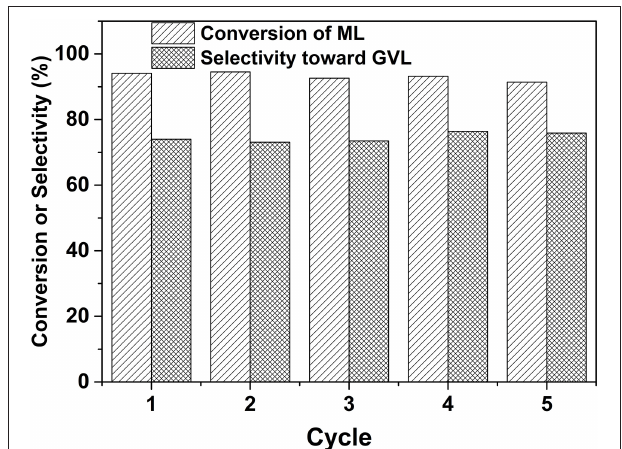
FIGURE 11 | Durability test of 2.0% Ru/11.7% SiW@UiO − 66 for the conversion of ML to GVL. Reaction conditions: 0.257g of ML, 50mg of catalyst, 15mL of H 2 O, 80 ◦ C, an H 2 pressure of 0.5 MPa H 2 , within a reaction period of